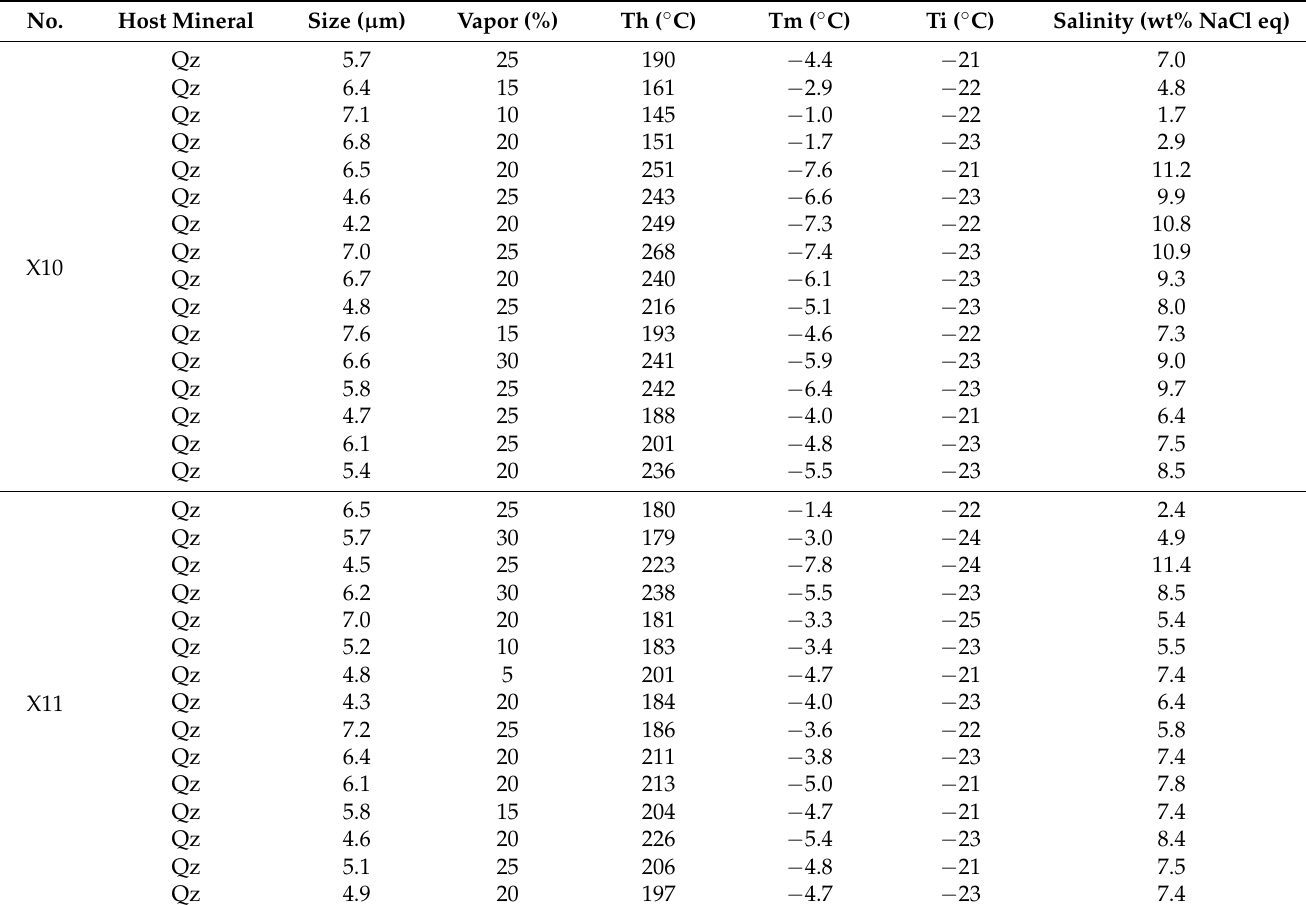
Table A3. Microthermometry results of primary fluid inclusions in Stage III of Xiaojiashan gold